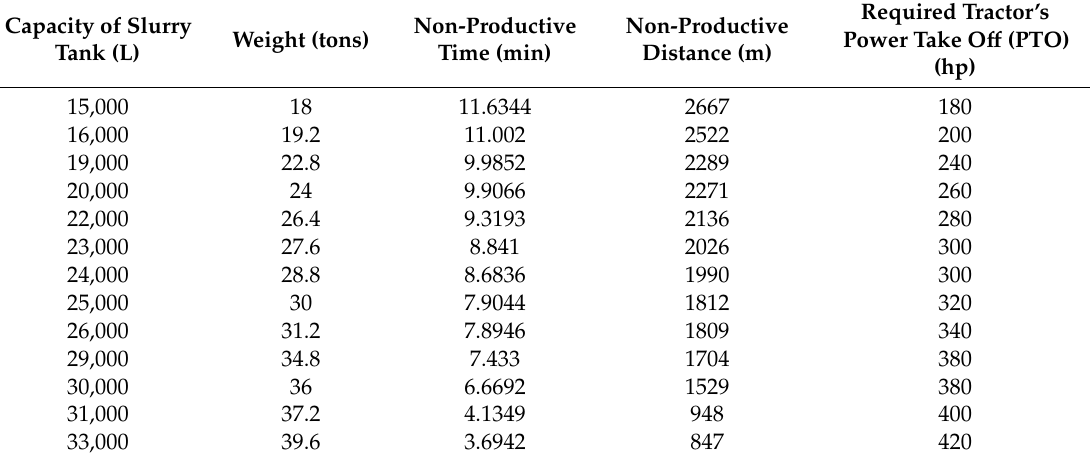
Table 9. The results of the optimal solution for possible